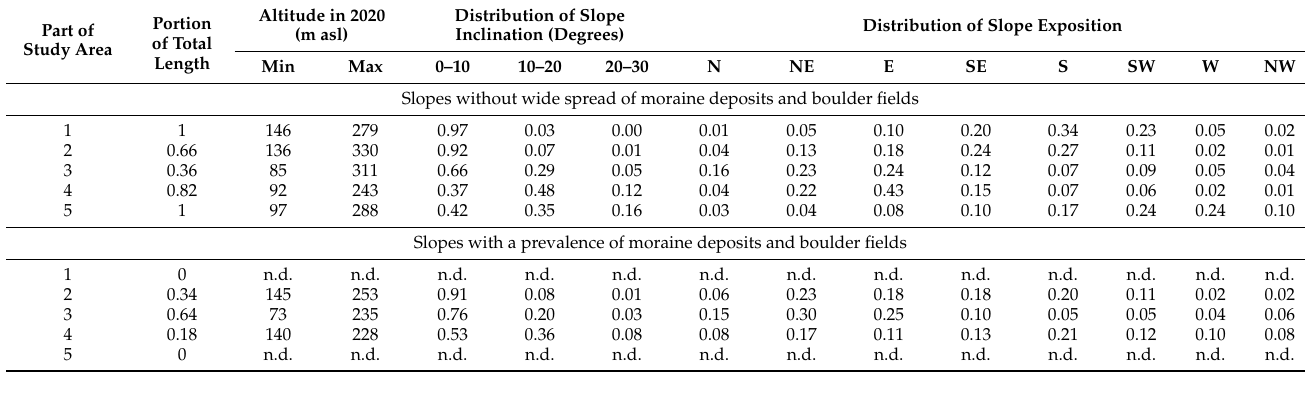
Table 5. Characteristics of open forest boundary in the studied subregion of Polar Urals in 2020.